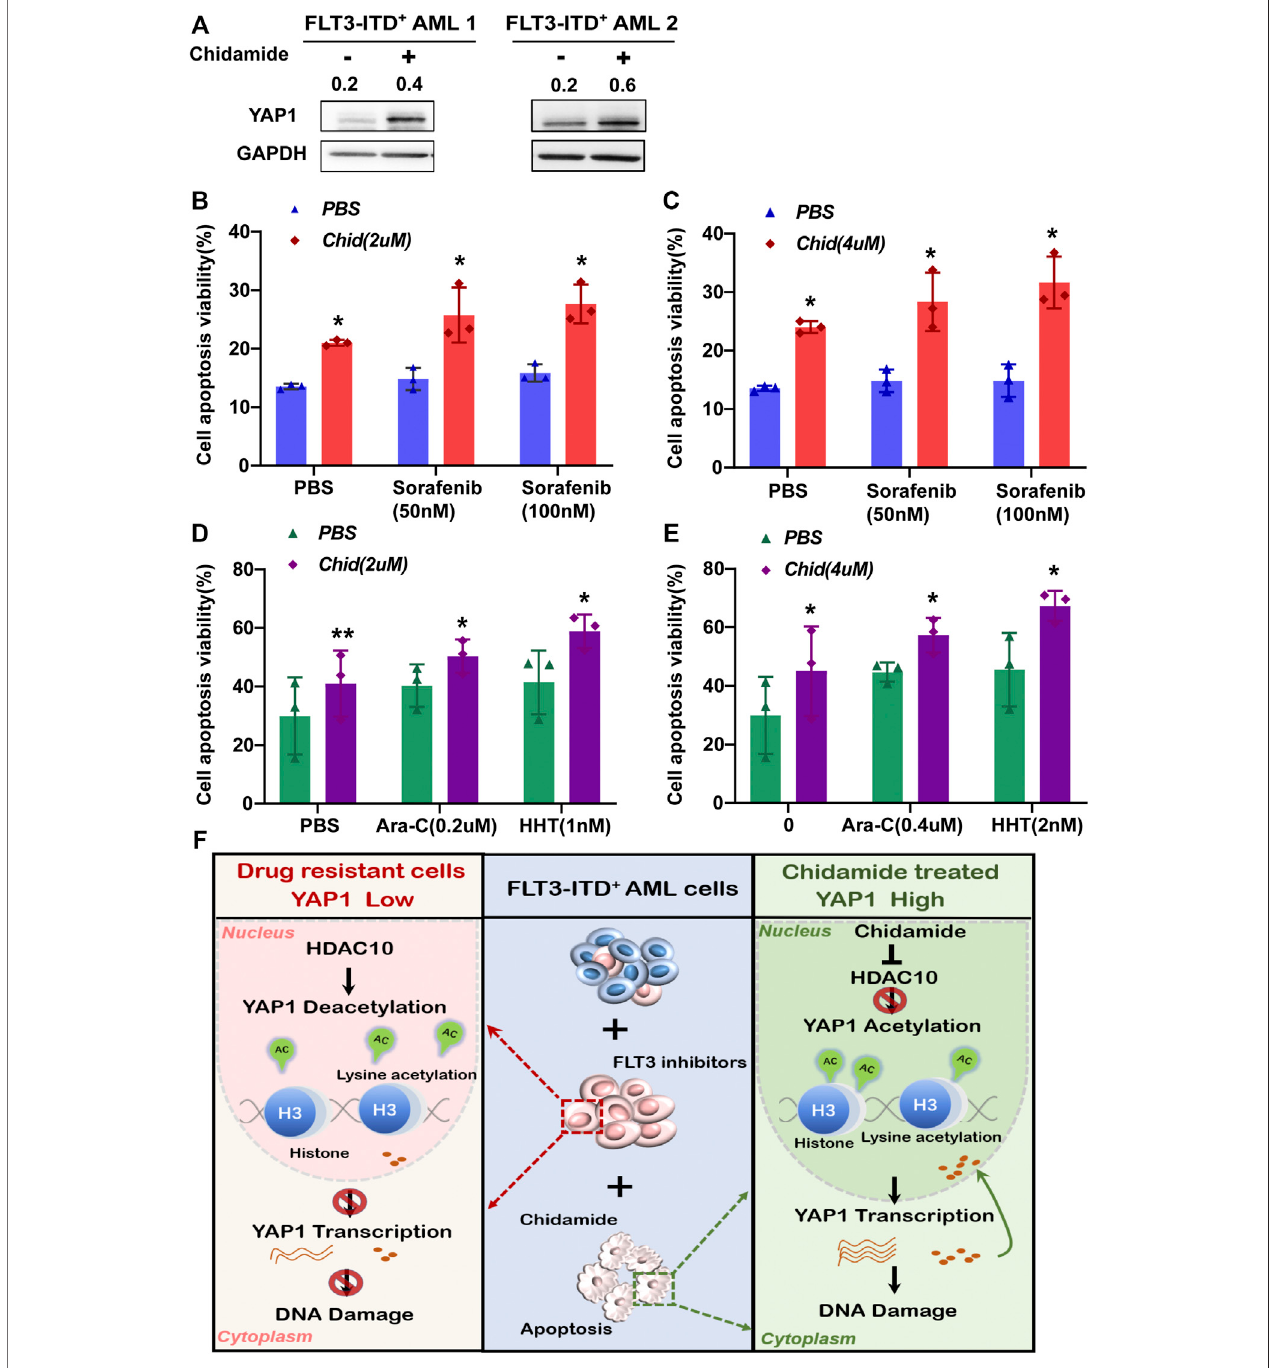
FIGURE 6 | Chidamide-potentiated YAP1 expression and the combination chidamide with FLT3 inhibitors or chemotherapy agents synergistically promoted apoptosisintheacquired resistant FLT3-ITD + AMLcells ex vivo. (A) Expressionlevel ofYAP1wasanalyzed byWestern blotinFLT3-ITD + AMLcellsafter treatmentwith chidamide for 24 h. (B) and (C) Apoptosis rate was analyzed by fl ow cytometry in relapse FLT3-ITD + AML patient cells after treatment with chidamide (2 or 4 μ M) combined with sorafenib (50 or 100 nM). (D) and (E) Apoptosis rate was analyzed by fl ow cytometry in relapse FLT3-ITD + AML patient cells after treatment with chidamide (2 or 4nM) combined withHHT (1 or 2 nM) or Ara-C (0.2 or 0.4 μ M). (F) Schematic summary ofthisstudy. HDAC10mediates the chemoresistance ofFLT3-ITD + AML cells to FLT3 inhibitors by deacetylating YAP1. Targeting the HDAC10 sensitizes FLT3-ITD + AML cells to FLT3 inhibitor treatment by enhancing acetylation of YAP1 through acetyl H3K27, promoting its transcriptional control, and strengthening nuclear YAP1-induced DNA damage repair. Data are shown as mean ± SD of three independent experiments; * p < 0.05; ** p < 0.01.